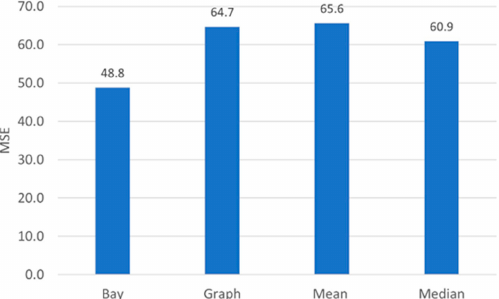
Figure 16. Test Set. MSE of the Bayesian estimator (Bay), the linear estimate obtained averaging over neighboring graph vertices (Graph), the linear estimate obtained averaging over spatially adjacent vertices (Mean) and the nonlinear estimate obtained as the median over spatially adjacent vertices (Median).